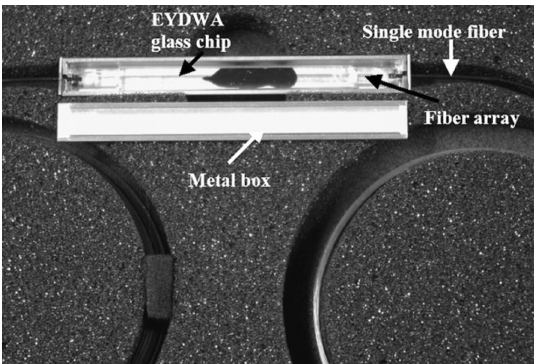
Figure 9. Photo of a packaged EYDWA device. Standard single mode fibers are pigtailed to both the input and output ends of the channel waveguide. The glass chip is then mounted to a metal box to provide mechanical stability and easy handling. Reproduced from [155] with permission by